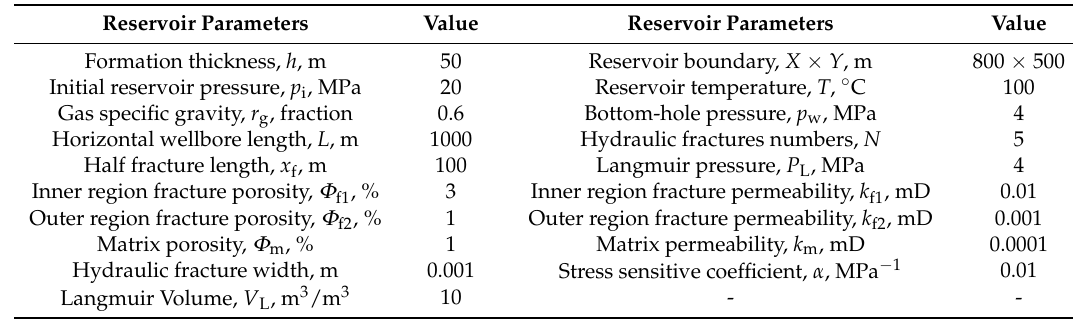
Table 1. Synthetic data used for the results discussion.